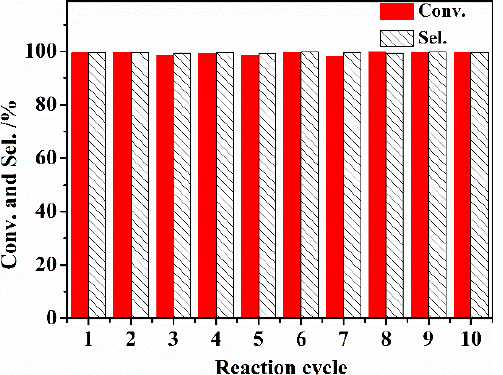
Figure 9. Recycling performance of AC-N-SO 4 H in benzaldehyde condensed with ethylene glycol. Note: Reaction conditions: 10 mL cyclohexane; 25 mmol benzaldehyde; molar ratio of ethylene glycol/benzaldehyde, 1.75; 0.13 g AC-N-SO 4 H; reaction temperature, 80 °C; reaction time, 5 h.